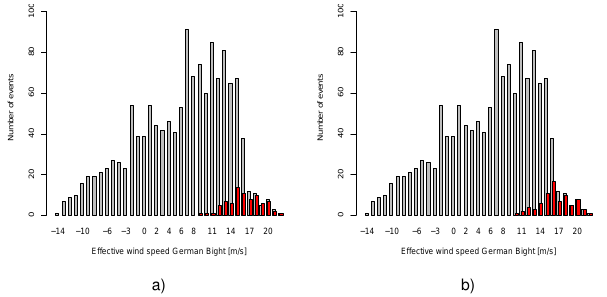
Figure 2. (a) Histogram of effective wind component over the Ger- man Bight region for all large-scale wind storm events (grey) and wind storm events which could be assigned to an observed storm surge (red). Effective wind component for assigned events are cal- culated using the maximum of the ERA-40 time step directly before and after the wind surge maximum. (b) Same as (a) but here effec- tive wind component for assigned events (red) is calculated using the maximum effective wind component during the whole large- scale wind storm